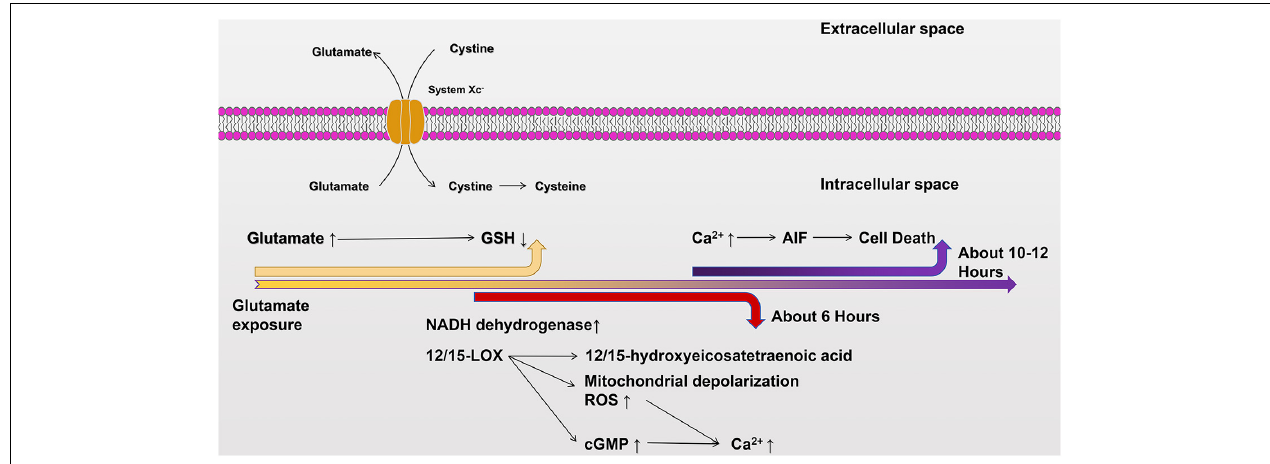
FIGURE 2 | The cellular death pathway of oxidative glutamate toxicity. Excessive accumulation of glutamate in the extracellular environment inhibits cystine uptake through System Xc − , resulting in GSH deficiency in cells. Mitochondrial complex I increases about 6 h after glutamate exposure. At the same time, 12/15-LOX is activated and 12/15-hydroxyhexotetraenoic acid is produced, and 12/15-LOX directly damages mitochondria and increases production of ROS. Additionally, soluble functional acid cyclase is activated, and intracellular GMP content is increased. Subsequently, cGMP opens calcium channels and enables calcium influx. After glutamate exposure for about 10–12 h, ROS and intracellular calcium levels reach their peaks, and AIF is transferred from mitochondria to the nucleus, inducing nuclear coagulation and cellular